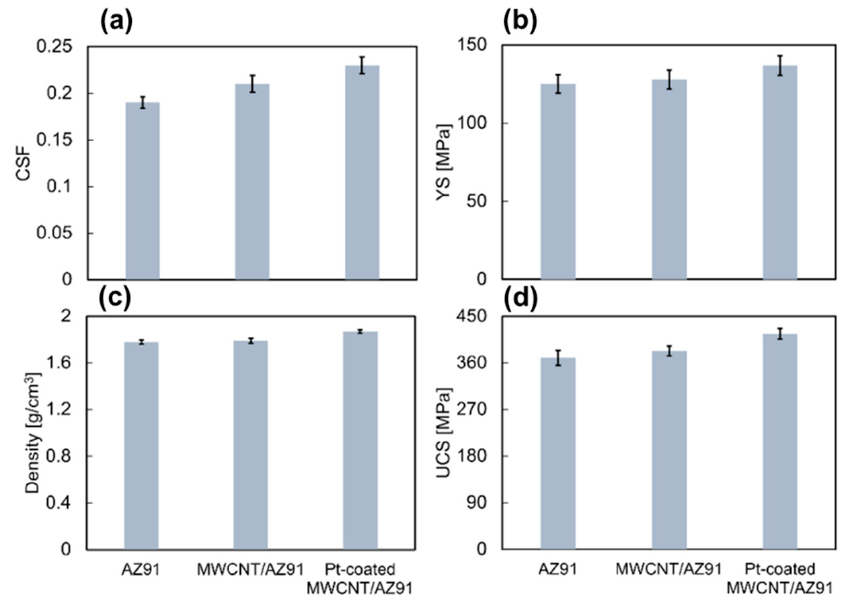
Figure 5. Comparison of ( a ) compression strain at failure (CSF), ( b ) yield strength (YS), ( c ) density, and ( d ) ultimate compressive strength (UCS) between pure AZ91, 0.05 wt% MWCNT/AZ91 composite, and 0.05 wt% Pt-coated MWCNT/AZ91 composite.